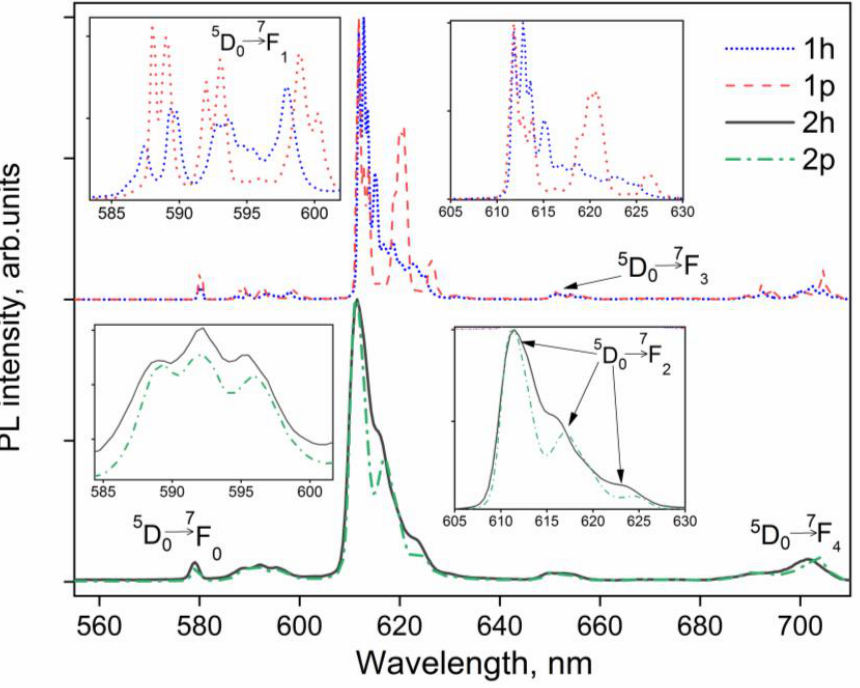
Figure 4. The luminescence spectra of 1h – 2p complexes in the crystalline phase excited at a wave- length of 360 nm at 77 K.